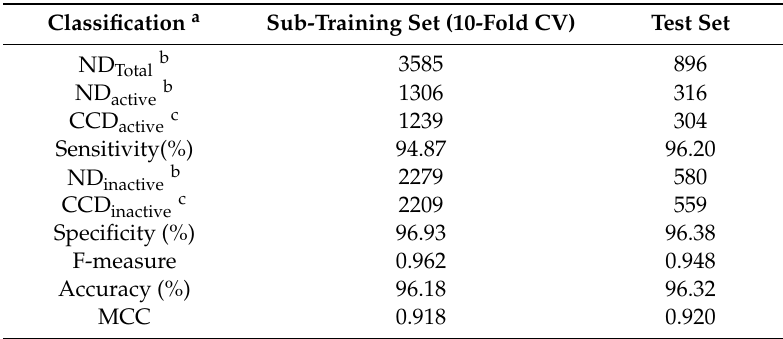
Table 4. Overall performance of the final mt-QSTR-random forest (RF) model.